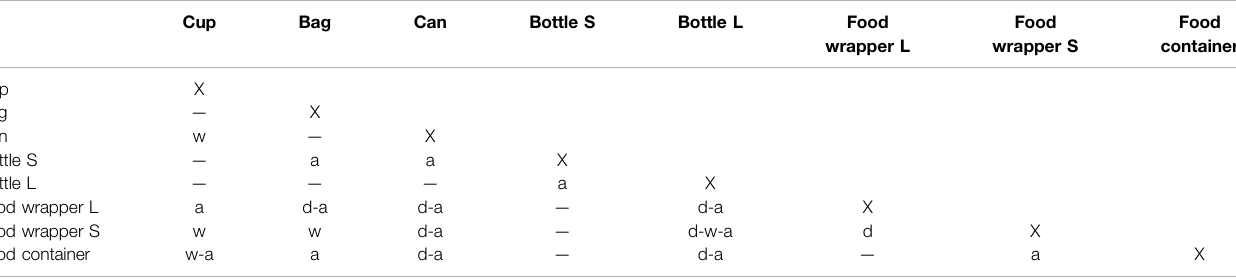
TABLE 1 | The signi fi cance in depth (d),width (w), and area (a) of the sonar footprints for the tested items compared toeach other. When there isa signi fi cant difference, the depth, width or area (d-w-a) is